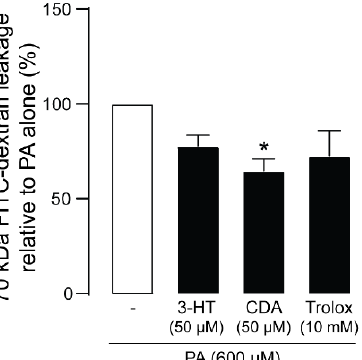
Figure 4. 3-Hydroxyterphenyllin (3-HT) and candidusin A (CDA) prevent palmitic acid (PA)–induced podocyte apoptosis. Podocytes were cultured in 6-well plates and then incubated with 600 µ M PA in the presence or absence of 50 µ M 3-HT or CDA for 24 h. N -acetylcysteine (NAC) (10 mM) was used as a positive control. Annexin V/propidium iodide (PI) staining was performed. ( A ) The representative results of five independent experiments are shown. ( B ) Summary of the results. *** p < 0.001 compared with the control group; ### p < 0.001 compared with the PA ‐ treated group.